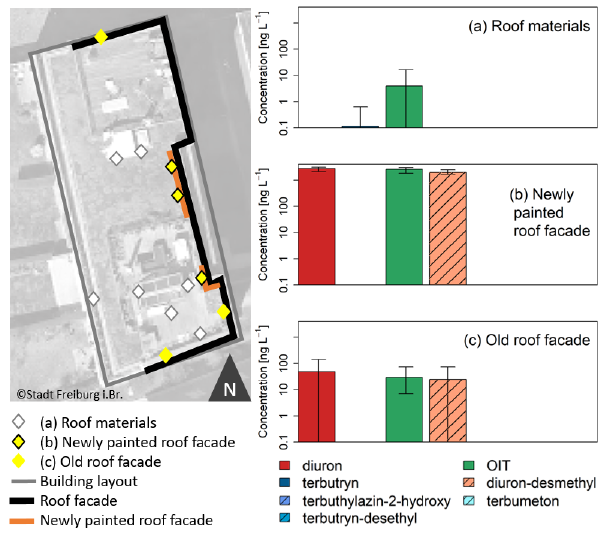
Figure 8. Schematic view of roof area of house 4 with sam- pling spots. Results of sampling for (a) roof materials include roof balustrade, railings, roofing foil, roof access, roof cladding, elevator shaft foil and grass foil, (b) newly painted roof facade, and (c) the old roof facade. Bars show the mean; lines show minimum and max- imum of the sample